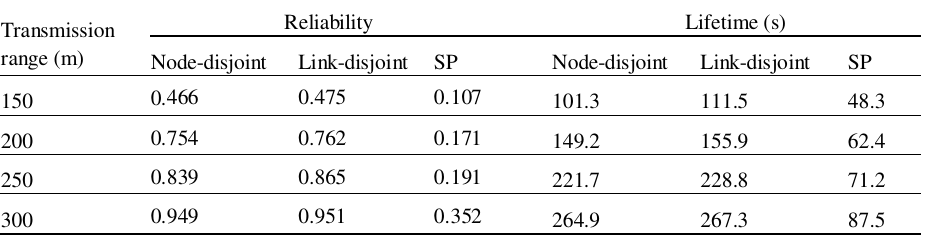
Transmission range